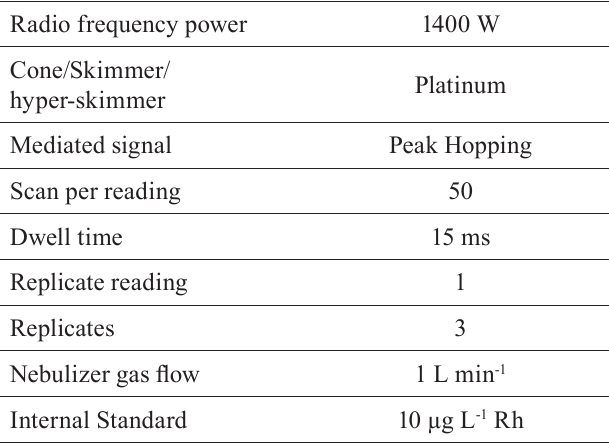
TABLE I - I CP-MS analysis conditions Radio frequency power